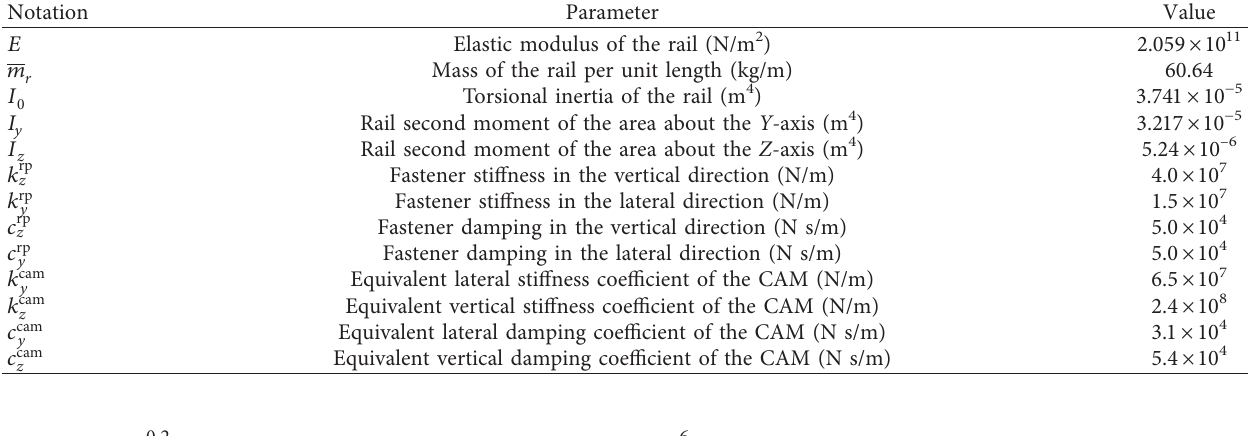
Table 2: Main parameters of the railway tracks used in the simulation.